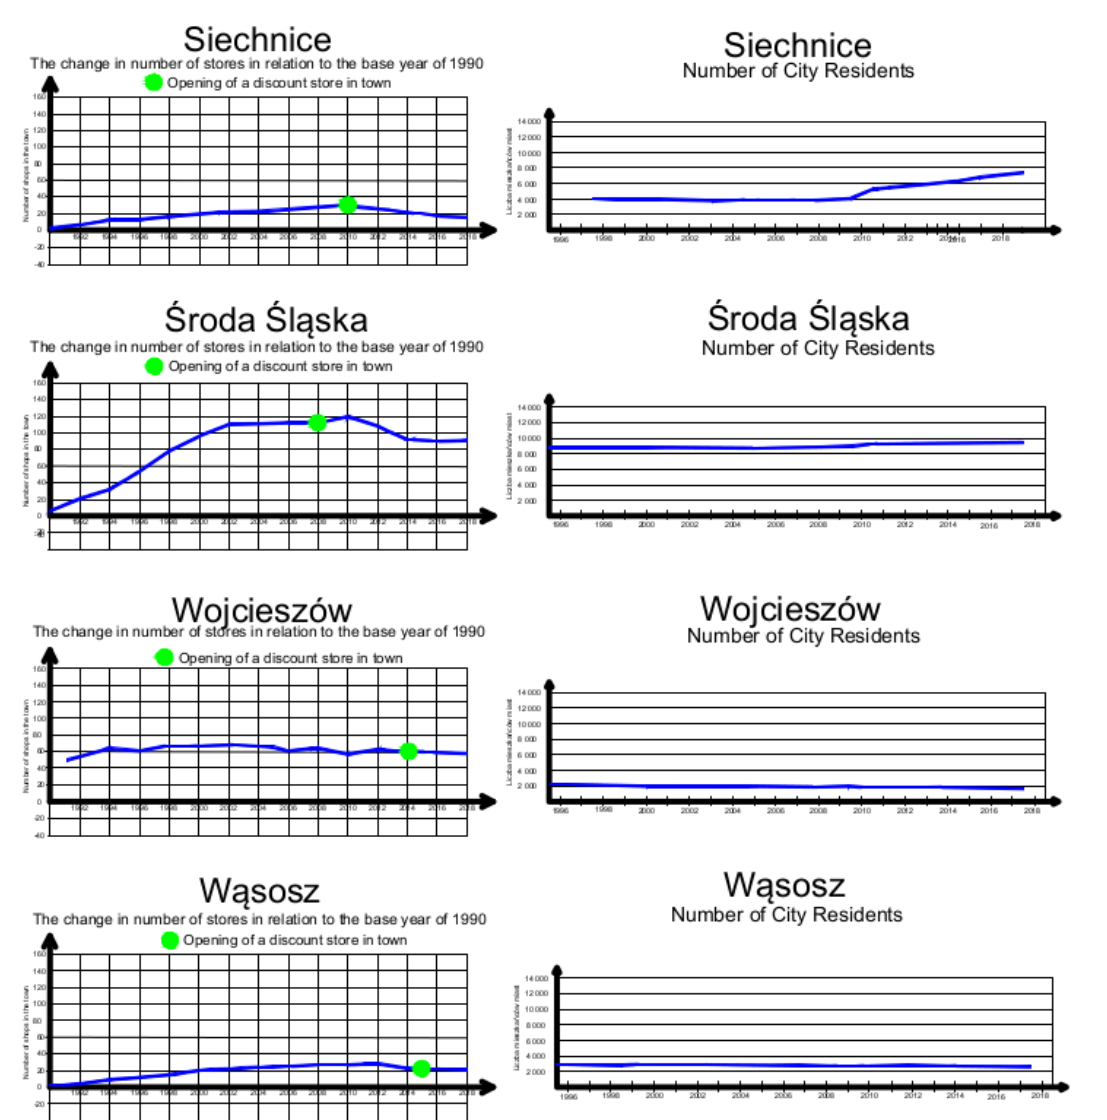
Figure 3. The change in number of stores in relation to the base year of 1990 date of opening of a discount store and the number of town residents.